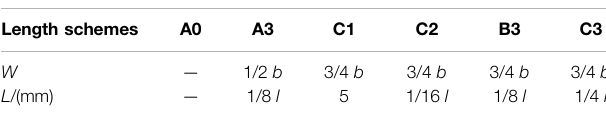
TABLE 5 | Tiny blade length